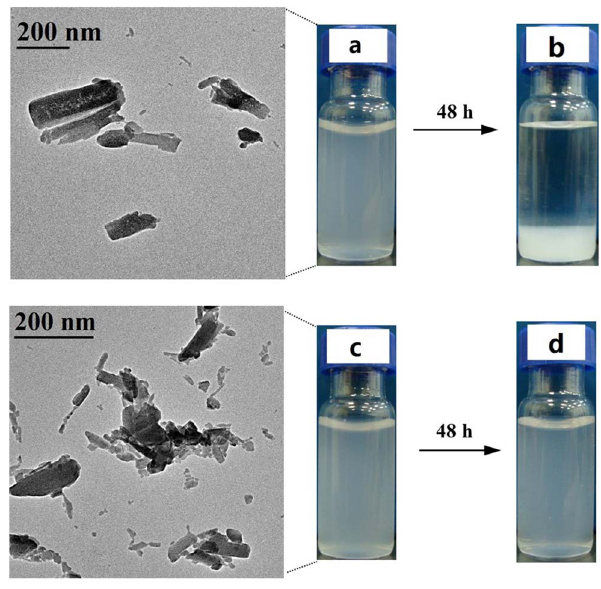
Figure 7. TEM pictures and sedimentation properties of HCl (a and b) and H 2 SO 4 (c and d) hydrolyzed SNC suspensions after 2 h and 48 h.